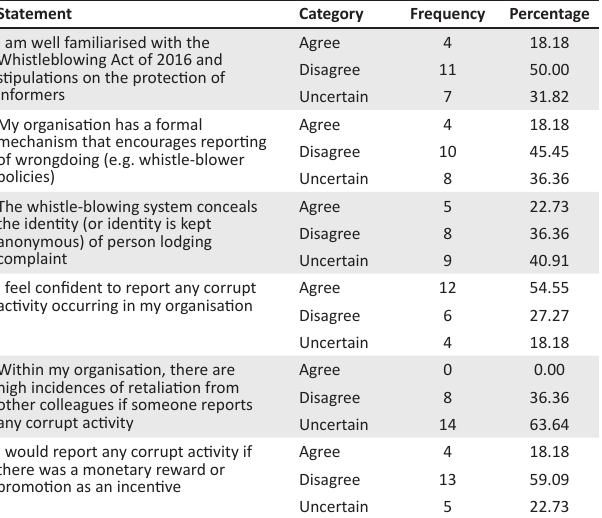
TABLE 1: Level of awareness and attitudes towards whistle-blowing